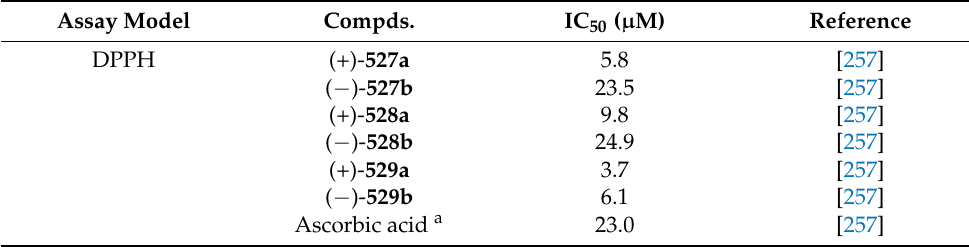
Table 7. Antioxidative activities of